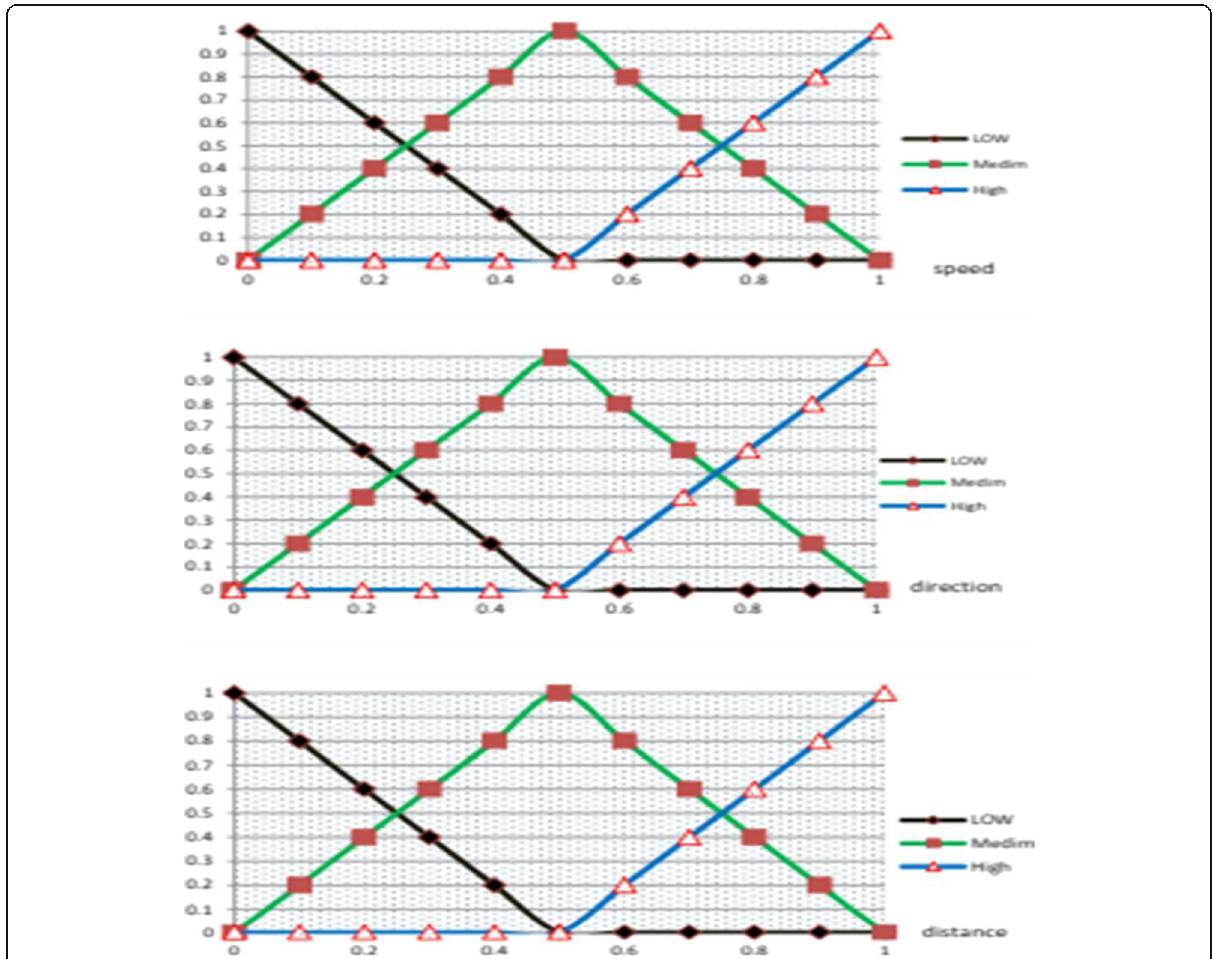
Fig. 4 Fuzzy member function for fuzzy input. For each of the mentioned criteria, the membership function is defined in the linguistic set. The words large, medium, and low are used to determine the rate of input criteria. The linguistic set of the member function of the fuzzy logic input parameters covers three values (low, medium, and high). The diagram of member functions of the speed difference, direction difference, and distance is presented in this figure. Although we could use other complex member functions as well, this triangular member function suits the proposed protocol, since it only needs to identify the best